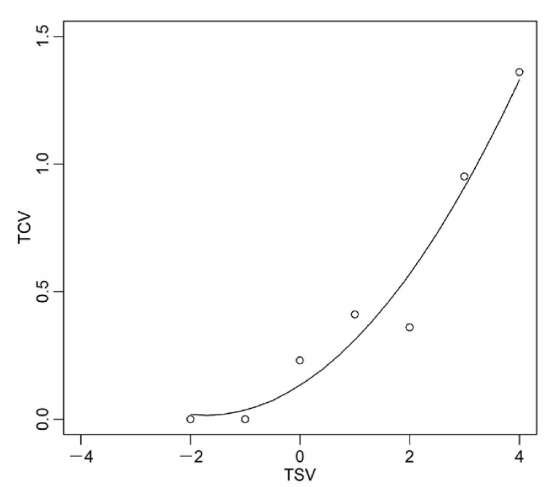
Figure 5. Correlation between TSV and